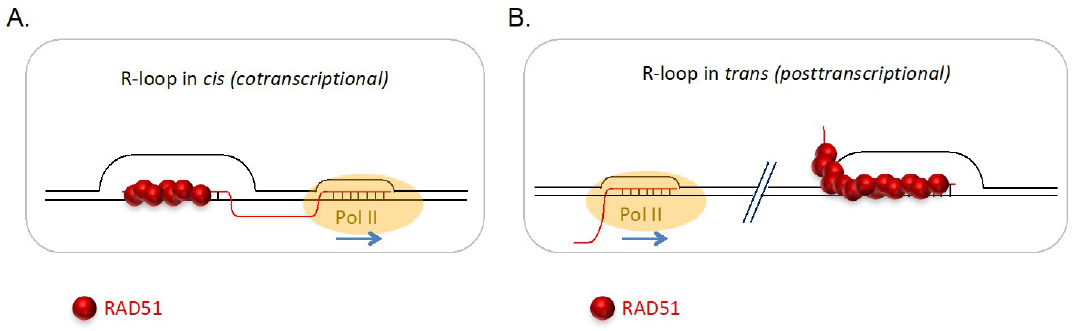
Figure 5. Co-transcriptional and post-transcriptional R-loops form upon hybridization of a nascent RNA transcript (red) with DNA (black). ( A ) Co-transcriptional R-loops form in cis when the nascent RNA binds to its DNA template upstream of the migrating transcription bubble. ( B ) Post- transcriptional R-loops form in trans when the nascent RNA detaches from its transcription site and then binds to a homologous and distant locus on the DNA strand. Blue arrows: progression of transcription. Red spheres: RAD51